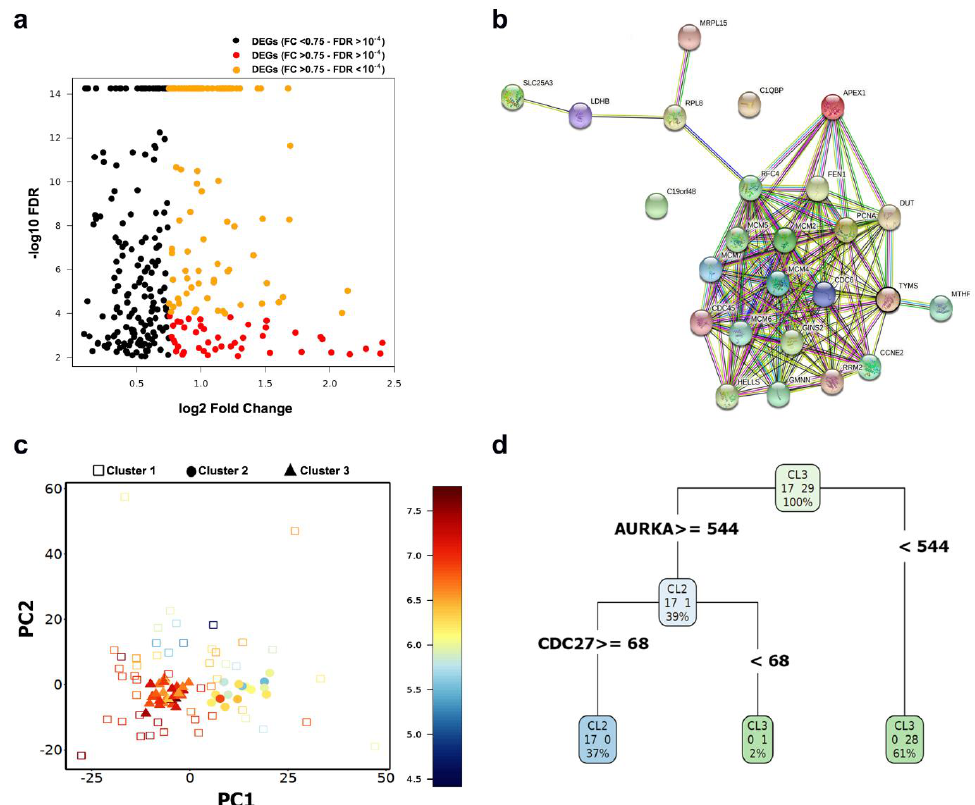
Figure 7. Biomarker discovery in Cluster 2. ( a ) Volcano plot showing the upregulated markers in Cluster 2. These markers were detected using binomial differential expression. ( b ) Network of downregulated DEGs in Cluster 2. ( c ) PCA plot visualizing cells labeled based on their cluster ID and color-coded based on the expression of TYMS . ( d ) Schematic figure explaining the RPART decision tree to predict the cluster identity of a target cell to belong to Cluster 2 or 3.